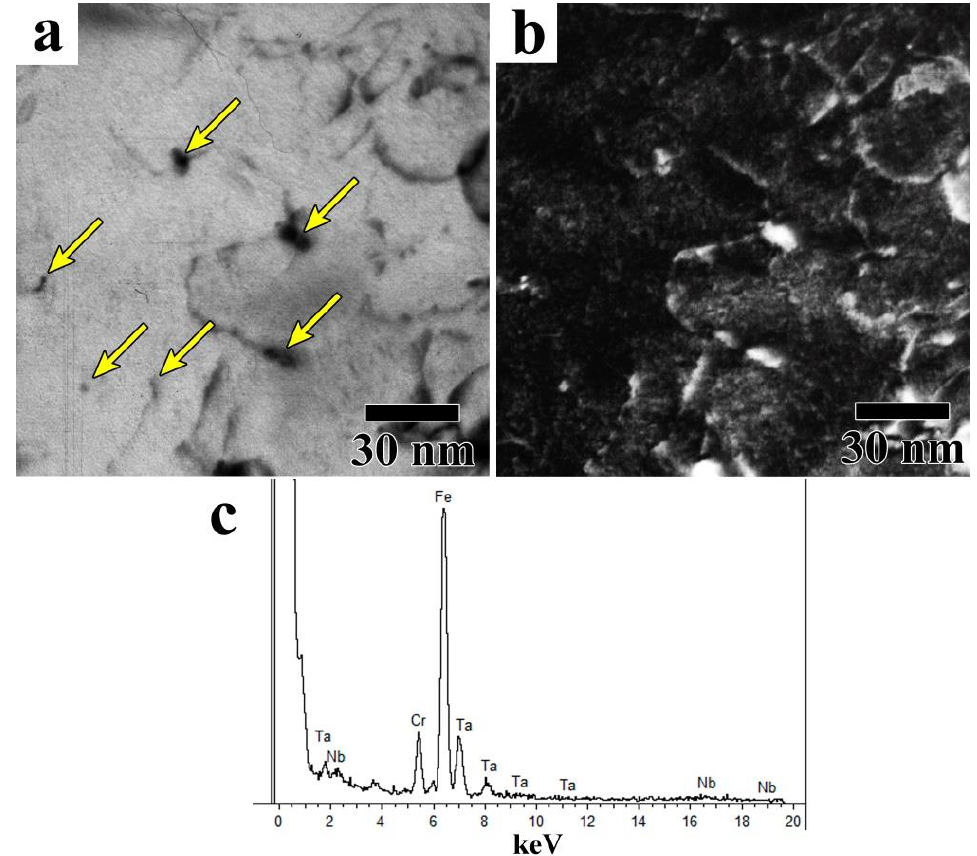
Figure 7. Bright-field ( a ) and dark-field ( b ) TEM images of the untempered HR+Q sample, illustrating the fine Ta-rich MX particles (highlighted by yellow arrows in ( a )) precipitated on the dislocations with the corresponding EDS spectra ( c ).